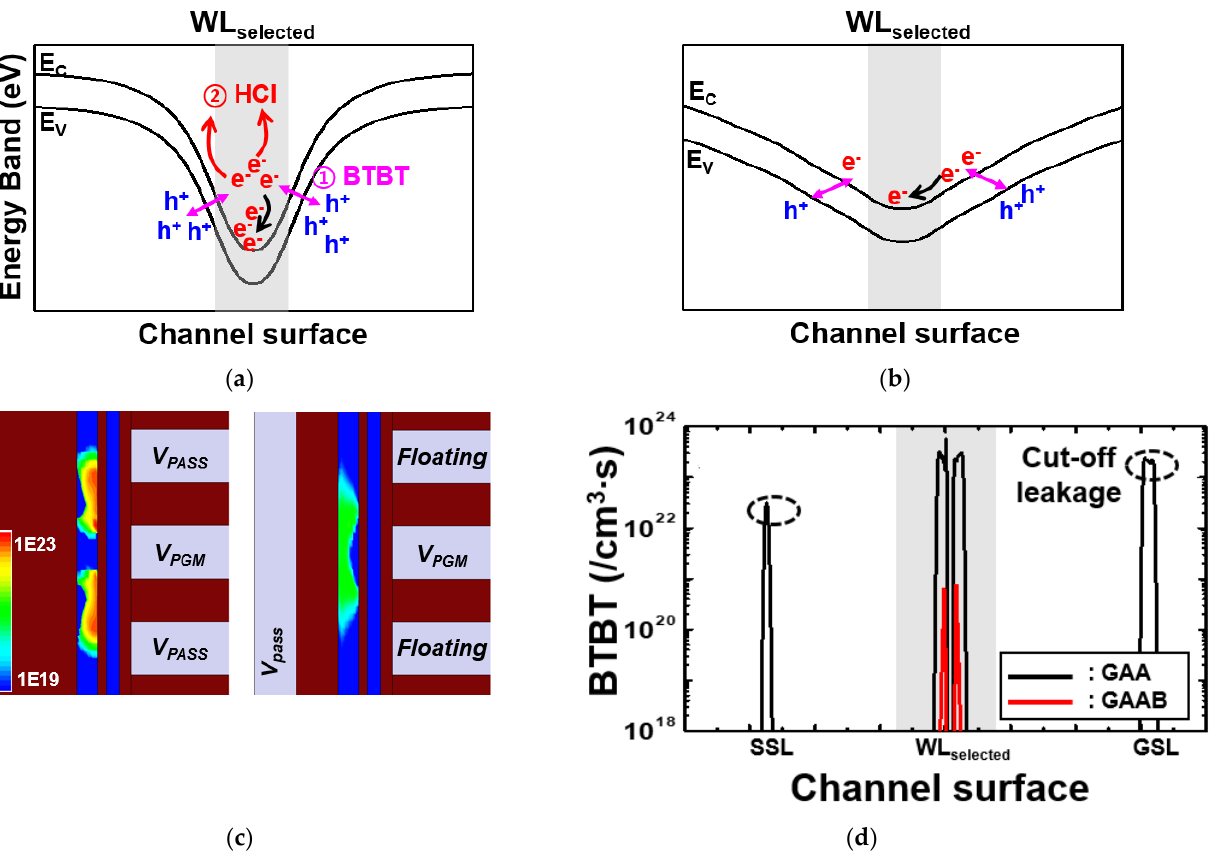
Figure 4. Simulation result of the inhibited BL band diagram at t boosting . ( a ) GAA, ( b ) GAAB NAND structure and constant BTBT generation contours. ( c ) GAA and GAAB NAND structure. ( d ) BTBT generation in the inhibited BL from GSL to SSL.